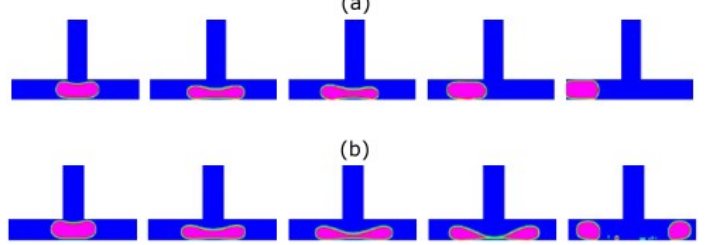
Figure 4. Droplet shapes from two-dimensional (2D) numerical simulations with time progressing from left to right in a symmetric T-junction: ( a ) non-breaking droplet; and, ( b ) breaking droplet. Reproduced with permission from [15].